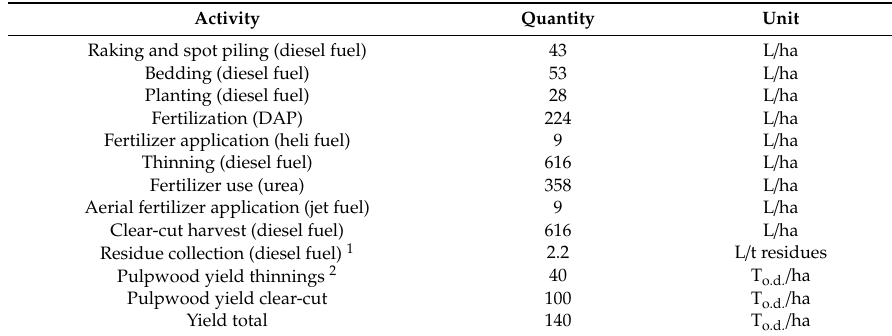
Table 1. Assumptions on forestry management and required fuel and fertilizer inputs, adapted from [29]. Forestry plantation management was assumed to include mid-rotation thinning, chemical and mechanical site preparation and some application of fertilizers during growth [29]. Fuel emissions are based on mobile diesel consumption